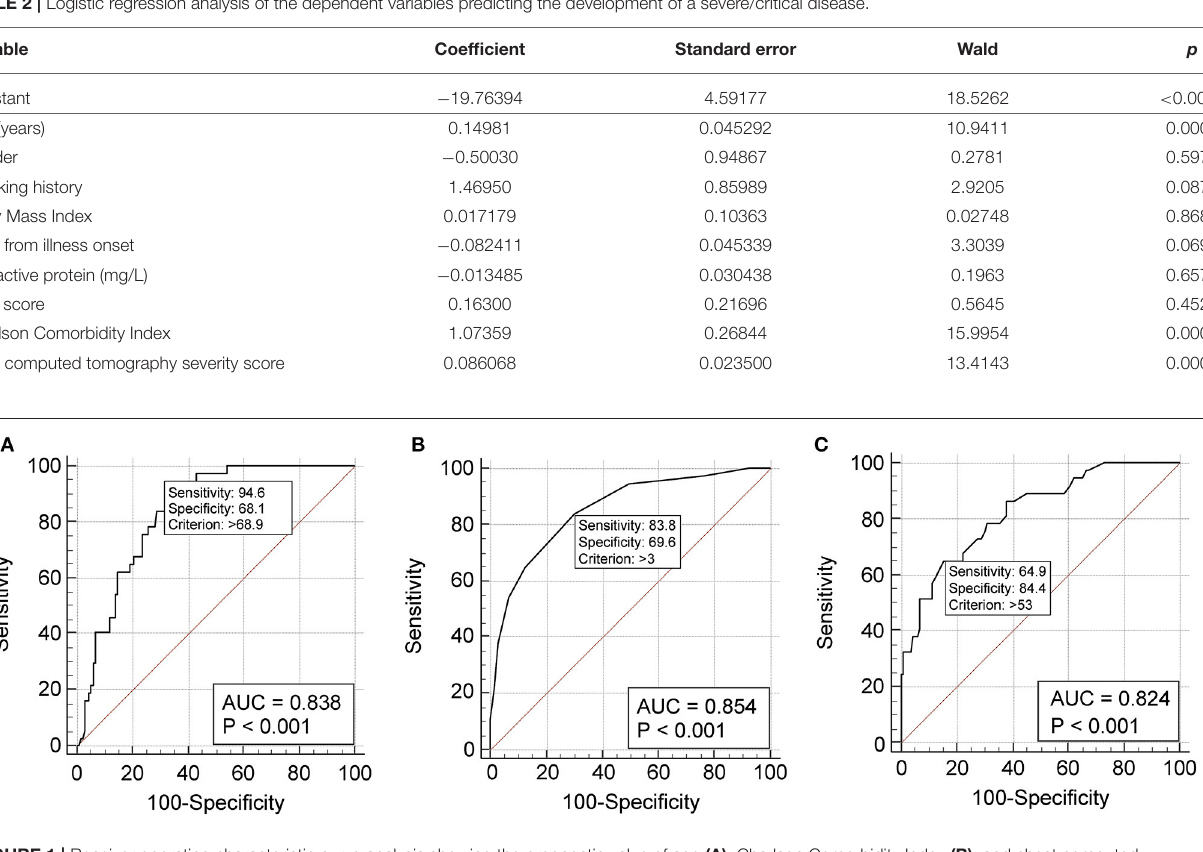
FIGURE 1 | Receiver operating characteristic curve analysis showing the prognostic value of age (A) , Charlson Comorbidity Index (B) , and chest computed tomography severity score (C) in the discriminative performance for severe/critical disease. (A) The cut-off value of 68.9 years predicts a severe/critical disease with 94.6% sensitivity and 68.1% specificity. The AUC-ROC is 0.836 (95% CI 0.785–0.896), the Youden index 0.627; (B) the cut-off value of 3 at Charlson Comorbidity Index predicts a severe/critical outcome with 83.8% sensitivity and 69.6% specificity. The AUC-ROC curve is 0.854 (95% CI 0.792–0.903), the Youden index